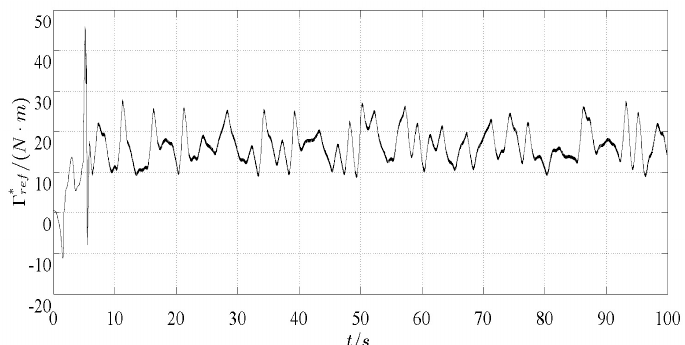
∗ without fault ∗ without fault. (cid:3045)(cid:3032)(cid:3033)∗ without fault ref without fault